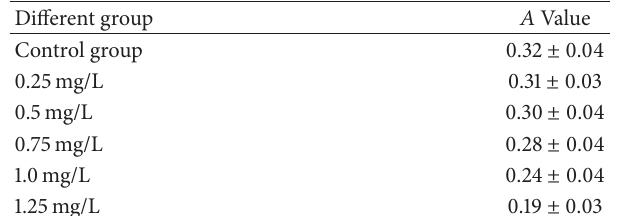
Table 4: The growth inhibiting rate of matrine to BT 325 cells.